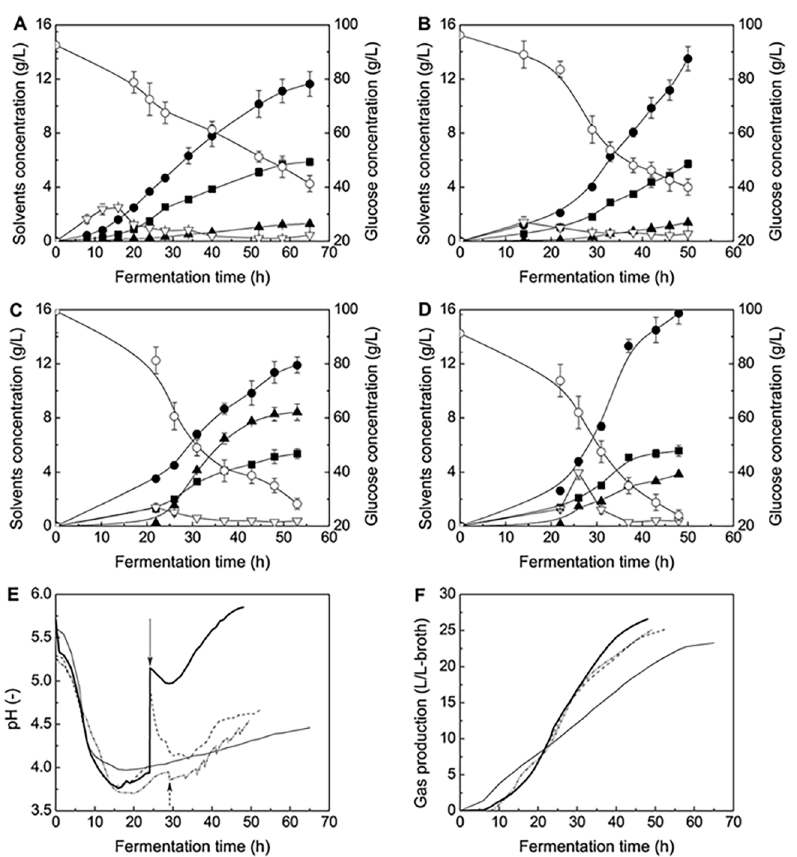
Fig 1. ABE fermentation performance with different operation strategies. (A) ABE fermentation by C . acetobutylicum (control, case #a). (B) ABE fermentation by C . acetobutylicum with exogenous butyrate addition (case #b). (C) ABE fermentation by co-culturing C . acetobutylicum / S . cerevisiae (case #c). (D) ABE fermentation by co-culturing C . acetobutylicum / S . cerevisiae in coupling with exogenous butyrate addition (case #d). ● : butanol; ■ : acetone; ▲ : ethanol; 5 : butyrate; (cid:6) : glucose. (E) - (F) Change patterns of pH and gas production with different operation strategies. Thin line: case #a (control); dash dot line: case #b; broken line: case #c; bold line: case #d. Dashed arrow: the instant of initiating the consecutive butyrate additions (case #b); solid arrow: the instant of adding S . cerevisiae culture broth (case #c) and S . cerevisiae culture broth/ concentrated butyrate solution (case